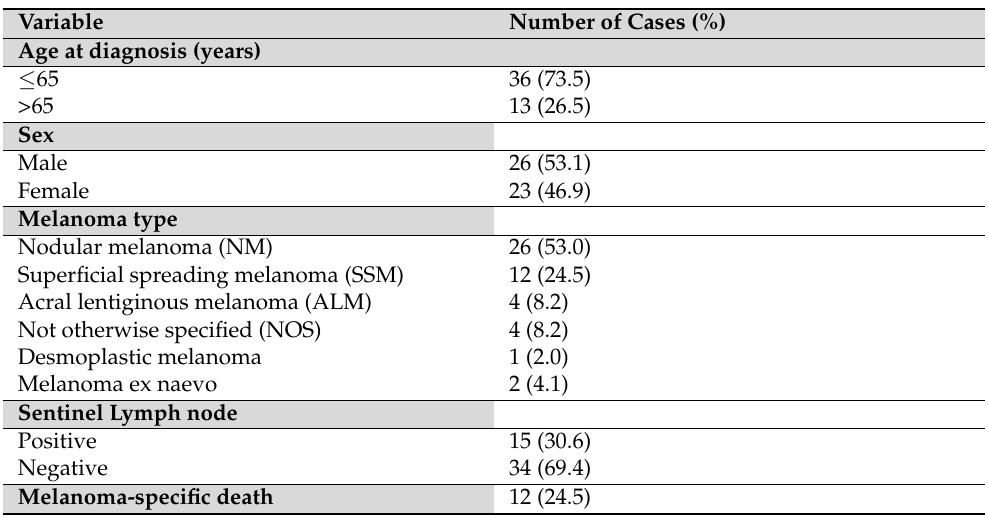
Table 1. Clinical data.